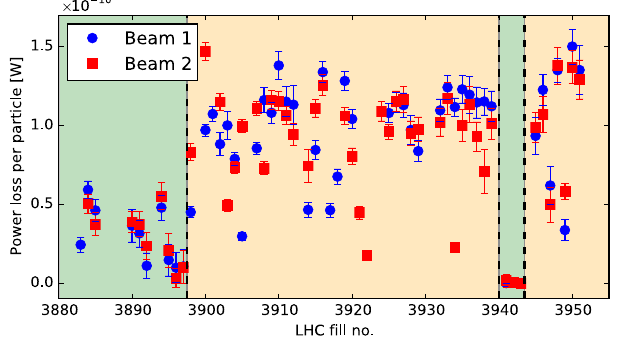
FIG. 15. Evolution of the maximum power loss per particle P p at 450 GeV during the first scrubbing run in 2015 for Beam 1 (blue circles) and for Beam 2 (red squares). The areas shaded in green correspond to periods with 50 ns beams and those shaded in orange to 25 ns beams. The effect of scrubbing is only visible when the beam parameters are similar, as for first fills with 50 ns beams of for fills 3933 – 3939. Outliers are correlated with fills with lower intensity per bunch and/or small number of